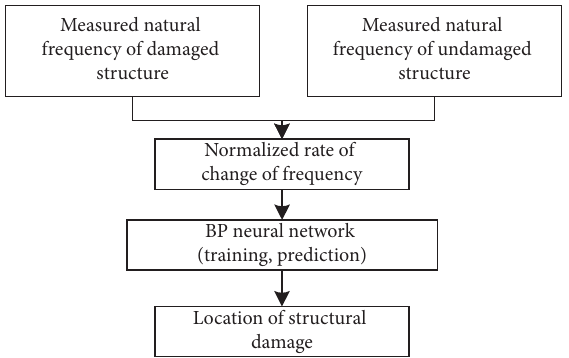
Figure 3: Structural damage location